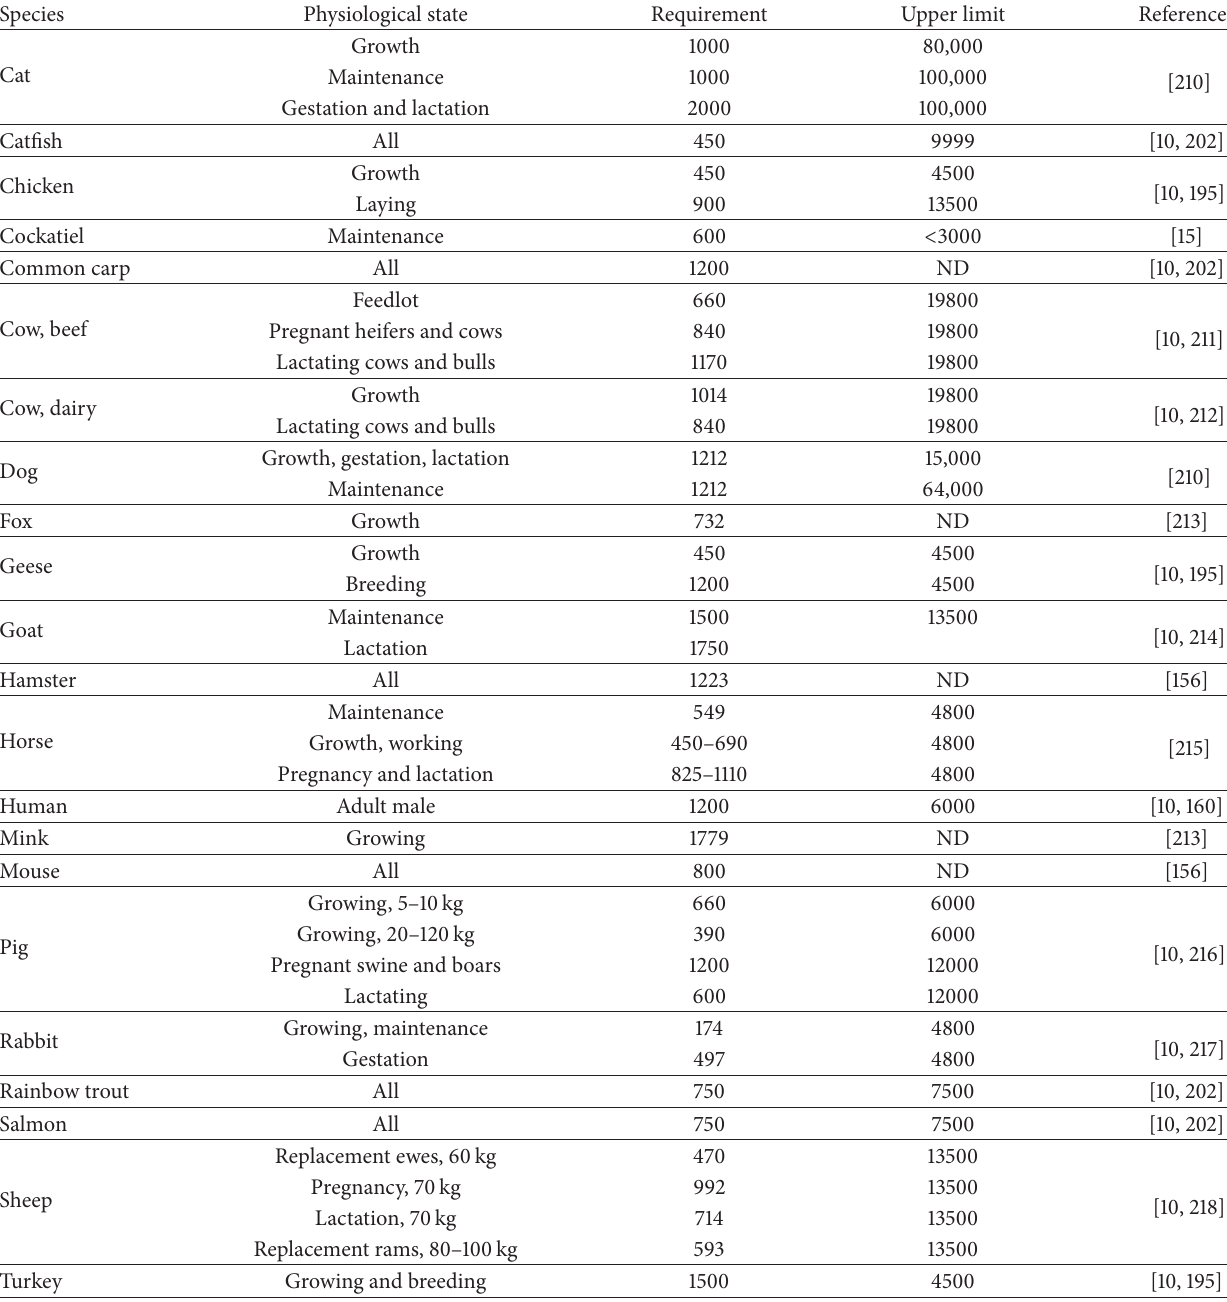
Table 1: Estimated vitamin A requirements and safe upper limits in RE 1 /kg dry matter in animal species. Requirements listed are the minimum requirements or adequate intake